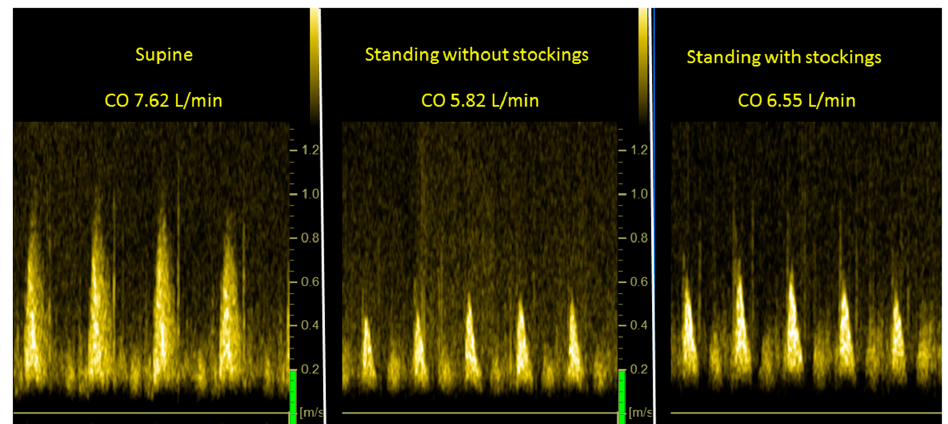
Figure 4. Example of cardiac output supine ( left panel ), at end-tilt without stockings ( middle panel ) and at end-tilt with stockings on ( right panel ). Legend Figure 4 CO: cardiac output (L/min). Images are suprasternal continuous wave Doppler echography showing time velocity integrals (VTI) and surface area is ex- pressed in centimeters.